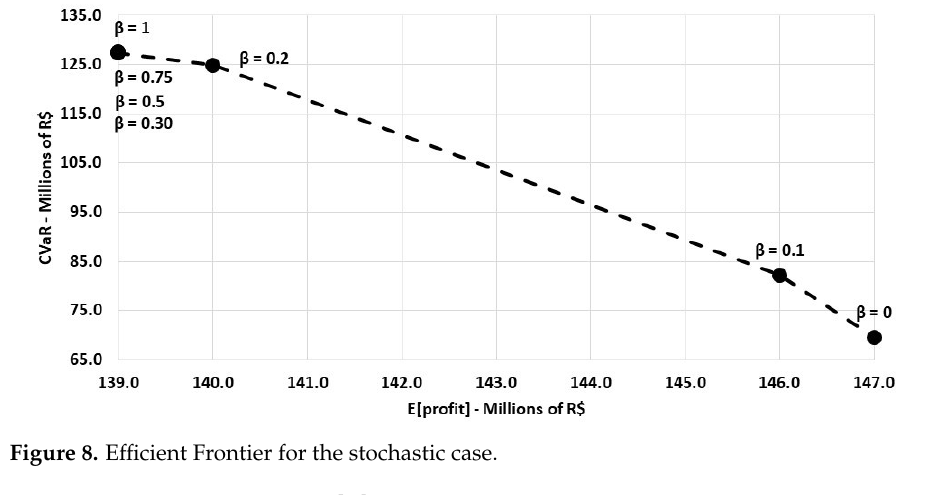
Figure 7. Optimal energy selling via forward contracts for different risk aversion levels- deterministic case.